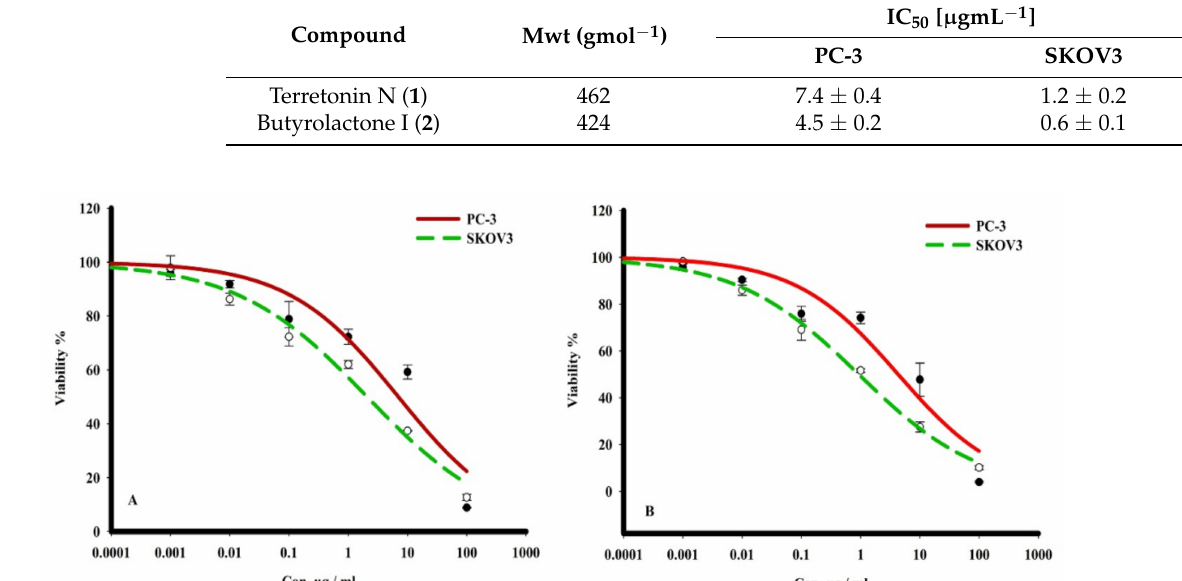
Figure 2. The dose response curves of the cytotoxicity of compounds A ( 1 ) and B ( 2 ) towards PC-3 and SKOV3 tumor cell lines, at different concentrations for 72 h. Cell viability was determined by SRB